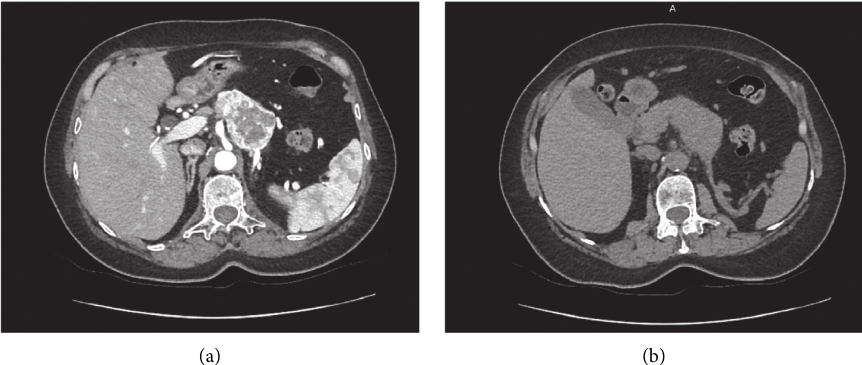
Figure 1: Computed tomography images of a tissular corporeal pancreatic mass, enhanced in periphery (a) with a central necrosis, invading the splenic vein (a, b).